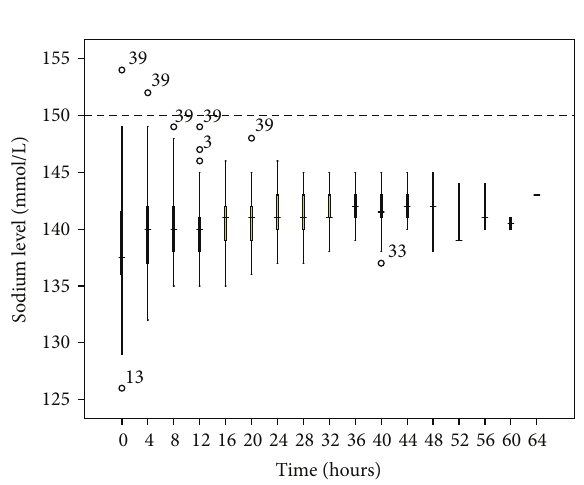
Figure 2: Circuit duration over time.